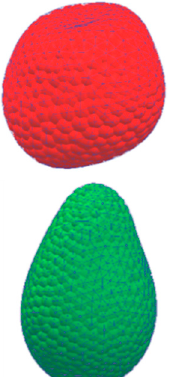
Figure 4. Illustration of the surface mesh and the clump-of-spheres approach used in YADE to approximate the shape of the tomato (top) and avocado (bottom). The images also show the surface mesh indicated by lines joining the centers of the spherical clumps adjacent to the surface.